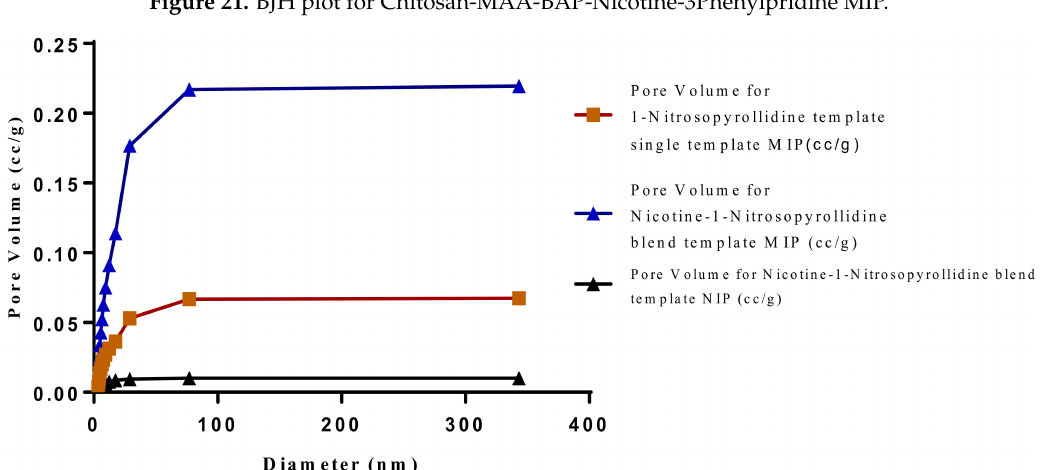
Figure 21. BJH plot for Chitosan-MAA-BAP-Nicotine-3Phenylpridine MIP.